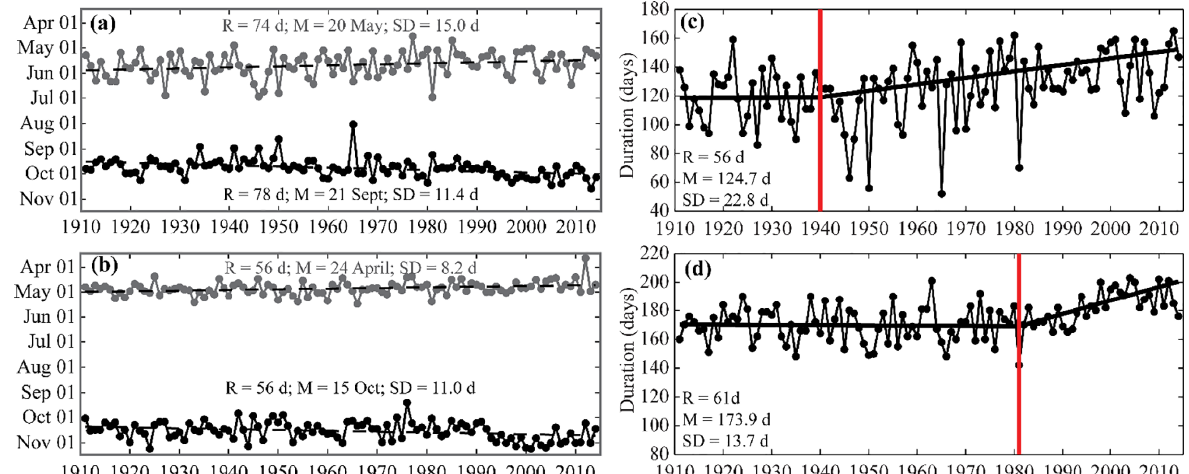
Figure 5. Stratification onset (gray) and overturn (black) dates for (a) Lake Mendota and (b) Fish Lake. Stratification duration for (c) Lake Mendota and (d) Fish Lake. Dark circles are modeled results and dashed lines denote the trend line for the 104-year period. In pan- els (a) and (b) , dashed lines represent the long-term trend in stratification onset and overturn dates. In panels (c) and (d) , solid red lines represent the timing of a statistically significant ( p <0.01) change in trend and solid black lines represent the trend during the periods. R is the range of onset, overturn, or duration; M is the mean date for onset, overturn, or duration length; and SD is the standard deviation in dates for the study period.